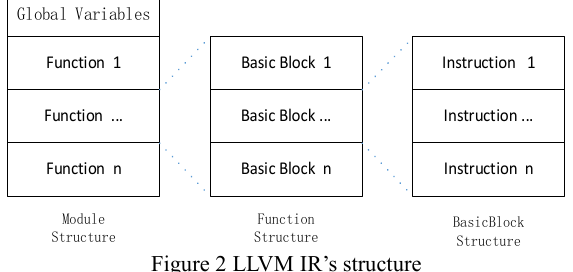
Figure 4 Pseudo code of symbolic